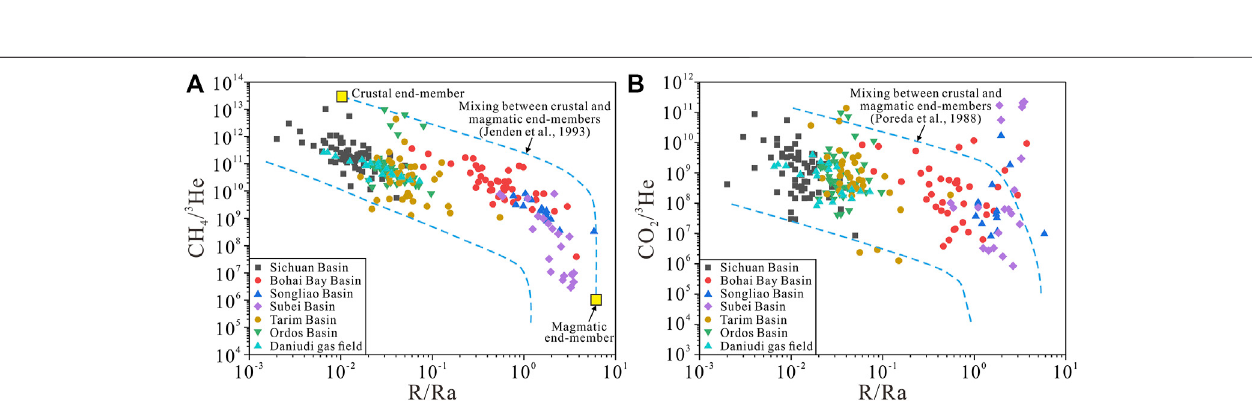
FIGURE 9 | Cross-plots of CH 4 / 3 He versus R/Ra (A) and CO 2 / 3 He versus R/Ra (B) of natural gas in the Daniudi gas fi eld and typical petroliferous basins in China. Crustal end-member, magmatic end-member, and the mixing line in Figure 1 are from Jenden et al . (1993), and the mixing line in Figure 1 is from Poreda et al . (1988).